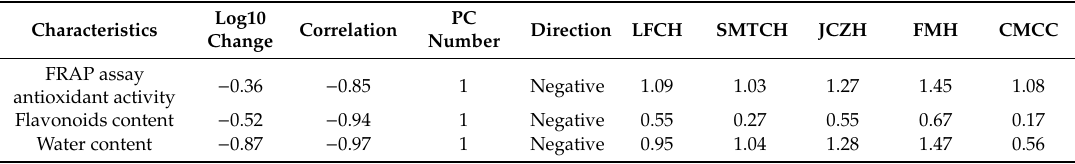
Table 3. Seed characteristics that strongly contributed to total variability in the principal analysis components.